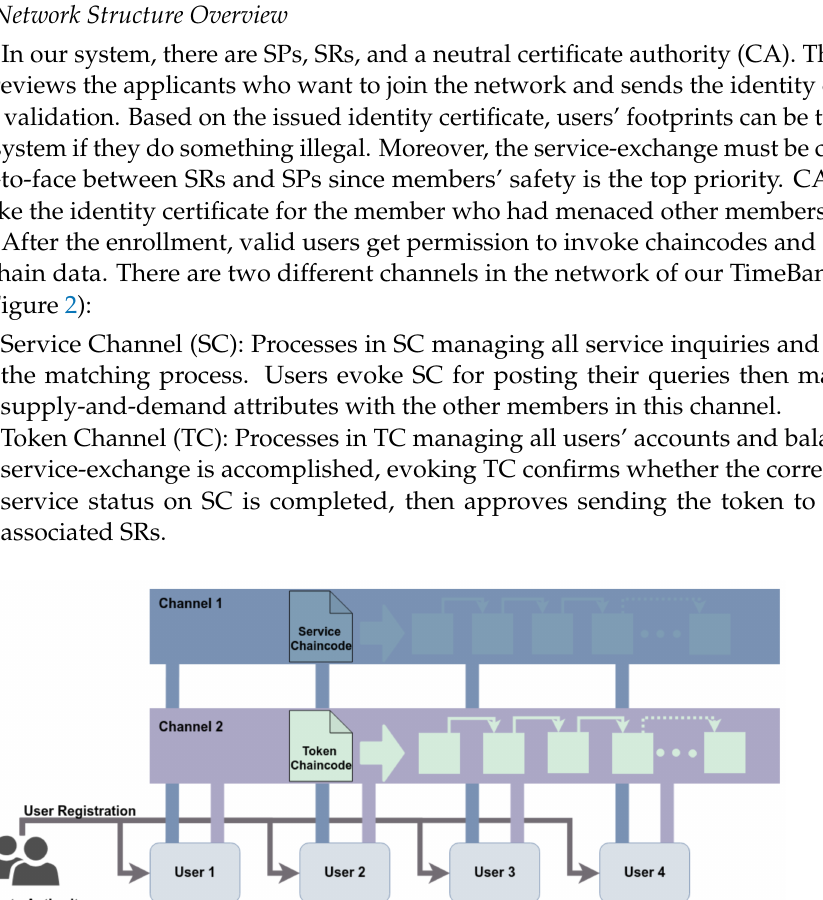
Figure 1. The processes of posting SP’s and SR’s service inquiries on the blockchain.